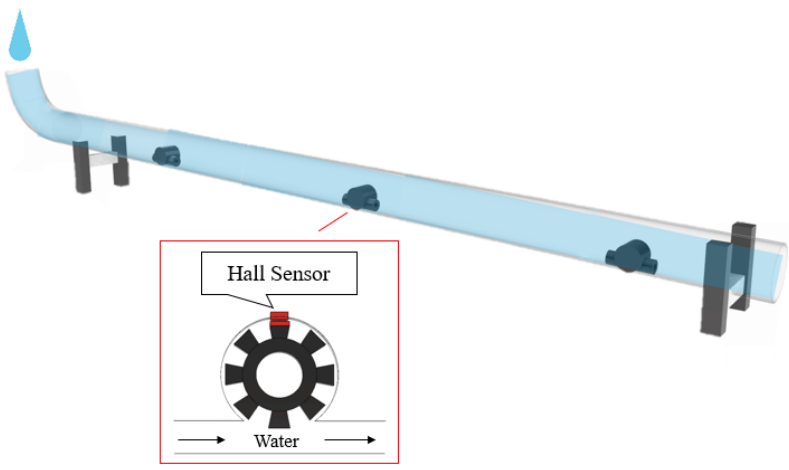
Figure 1. Schematic of hall sensors in the pipeline filled with water.